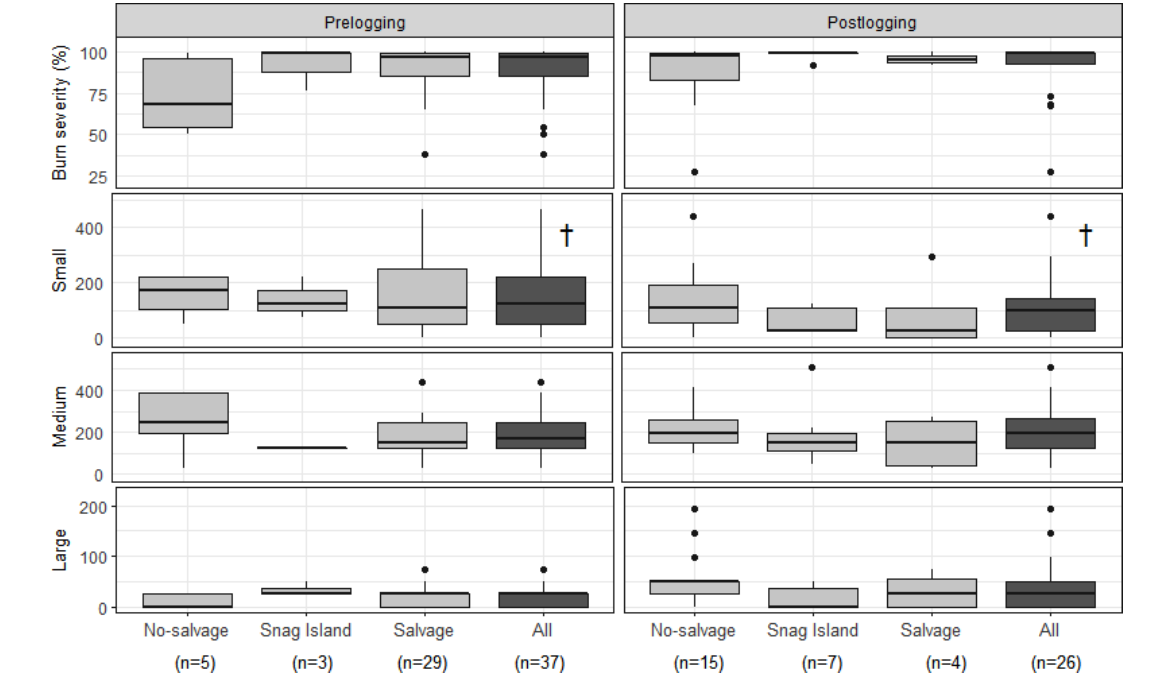
Fig. 4 . Black-backed Woodpecker ( Picoides arcticus ) nest site characteristics by treatment type before and after logging. Burn severity was calculated as an area-weighted mean in a 100 m-radius buffer around each nest. Snag densities were calculated as stems per hectare by diameter class. † Density of small snags in Black-backed Woodpecker nest sites averaged over all treatments was significantly lower in the post- than in the prelogging period (F1, 56 = 5.25, p =